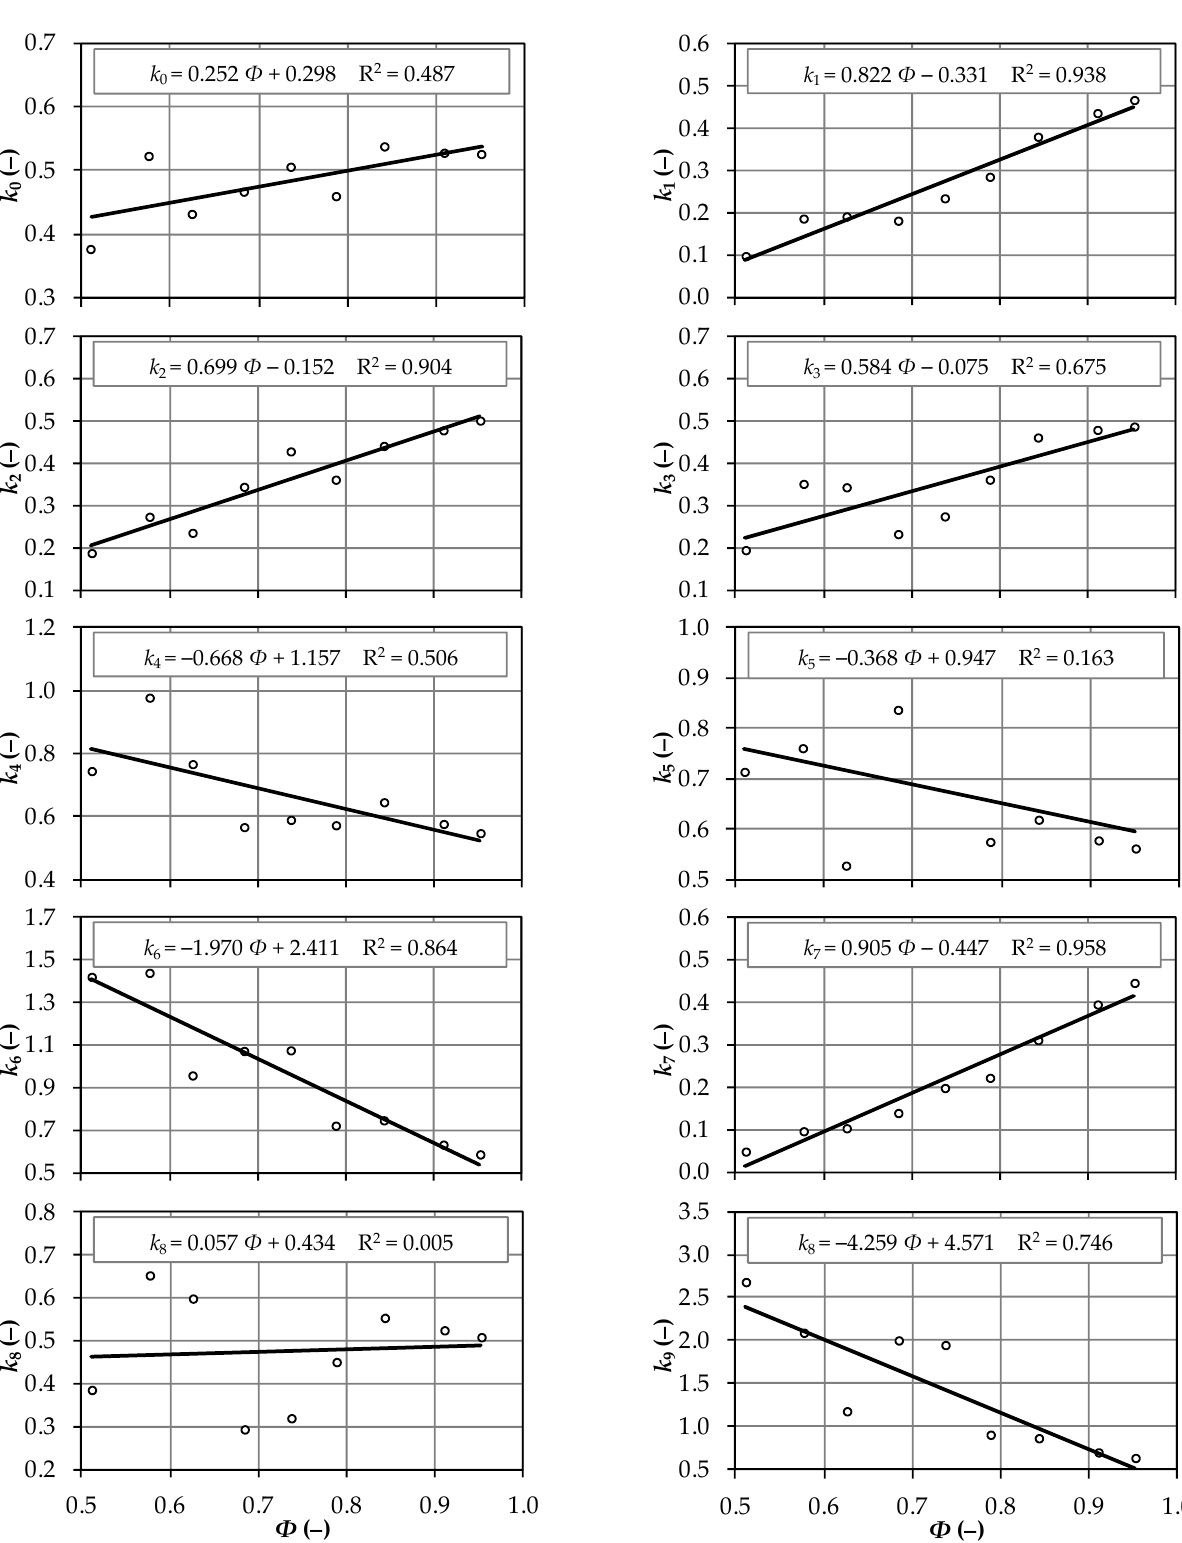
Figure 3. Relationships between the sphericity index and seed volume coefficients.